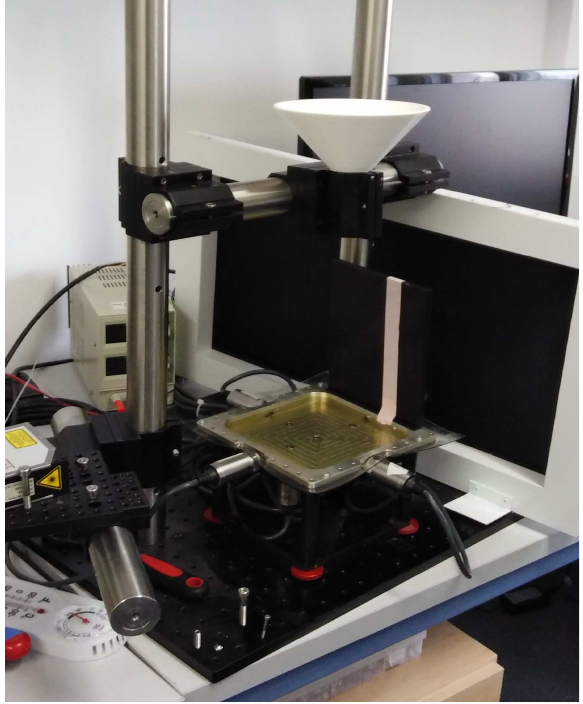
Figure 8. Image of the experimental mechanical pressure control